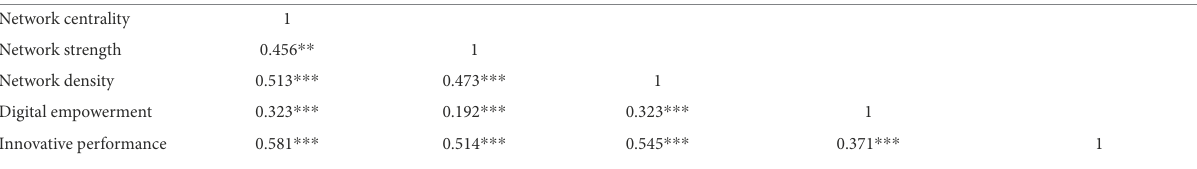
TABLE 6 Correlation analysis of study variables. Network centrality Network strength Network density